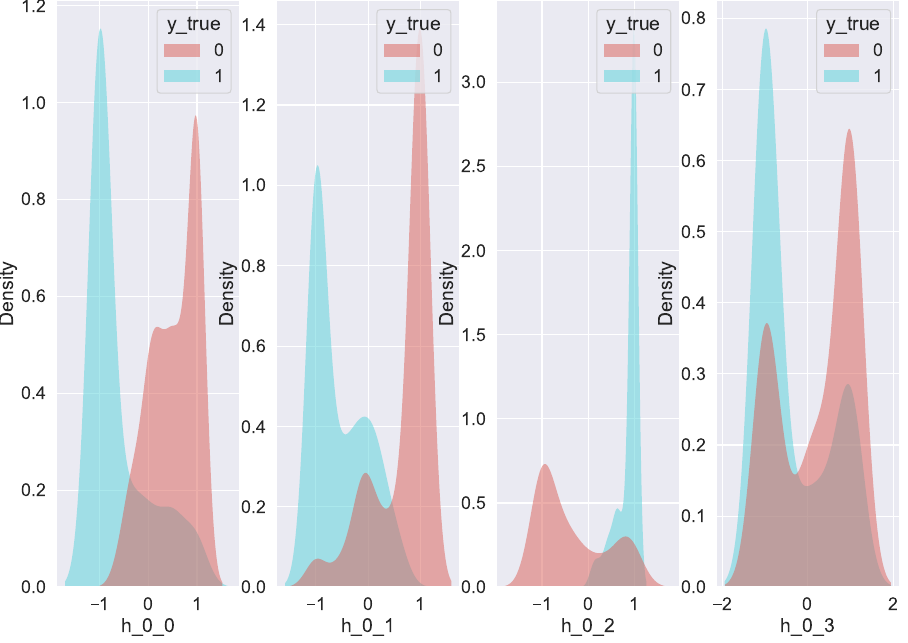
Figure A1. Histogram of binary activations for neurons in hidden layer zero in DL predictor for banknote authentication dataset. Each plot shows the activation density function per neuron discrim- inated by class (class 0 is shown in red, and class 1 is shown in